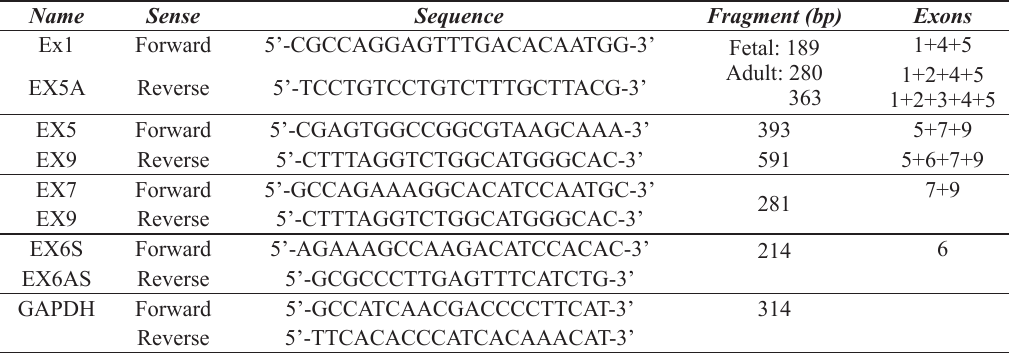
PCR pairs of primer sequences and expected product sizes (Vanier et al.